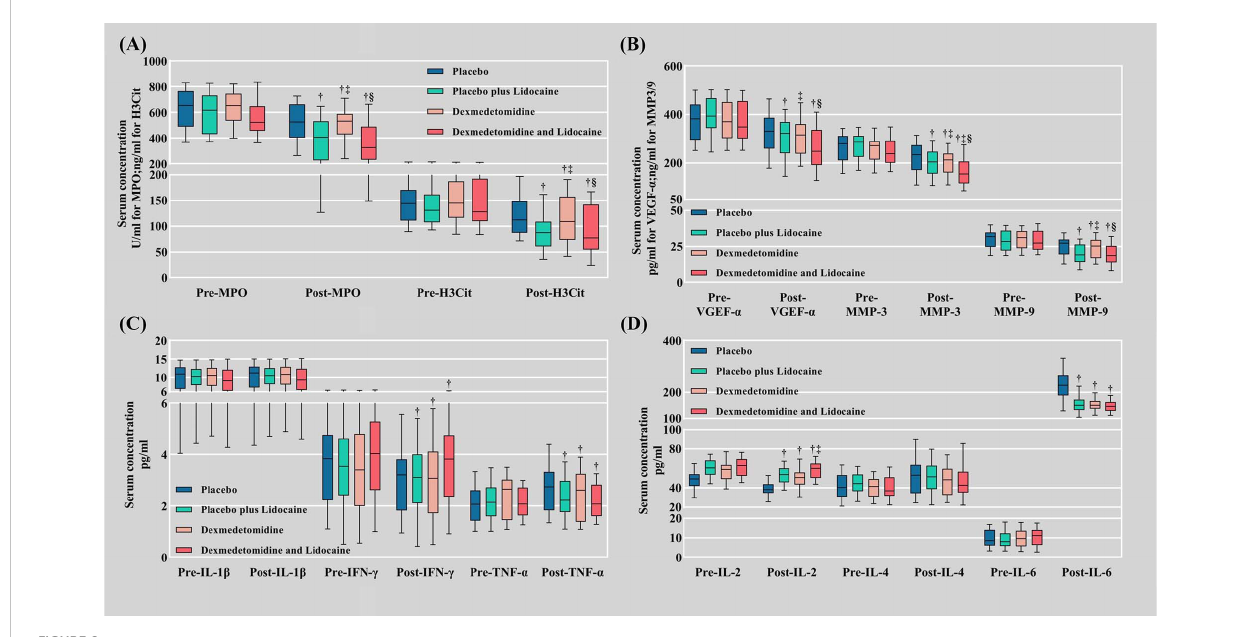
FIGURE 2 Serum biomarker levels. (A) Biomarkers of NET formation (MPO and H3Cit); (B) Metastasis biomarkers (VEGF- a , MMP-3, and MMP-9); (C) In fl ammatory factors (IL-1 b , IFN- g , TNF- a ); (D) In fl ammatory factors (IL-2, IL-4, and IL-6). Pre, preoperative; Post, postoperative; NETs, neutrophil extracellular traps; MPO, myeloperoxidase; H3Cit, citrullinated histone 3; VEGF-A, vascular endothelial growth factor-A; MMP-3, matrix metalloproteinase-3; MMP-9, matrix metalloproteinase-9. † Compared with the placebo group (C), the difference was statistically signi fi cant. ‡ Compared with the placebo plus lidocaine group (L), the difference was statistically signi fi cant. § Compared with the dexmedetomidine plus placebo group (D), the difference was statistically signi fi cant.